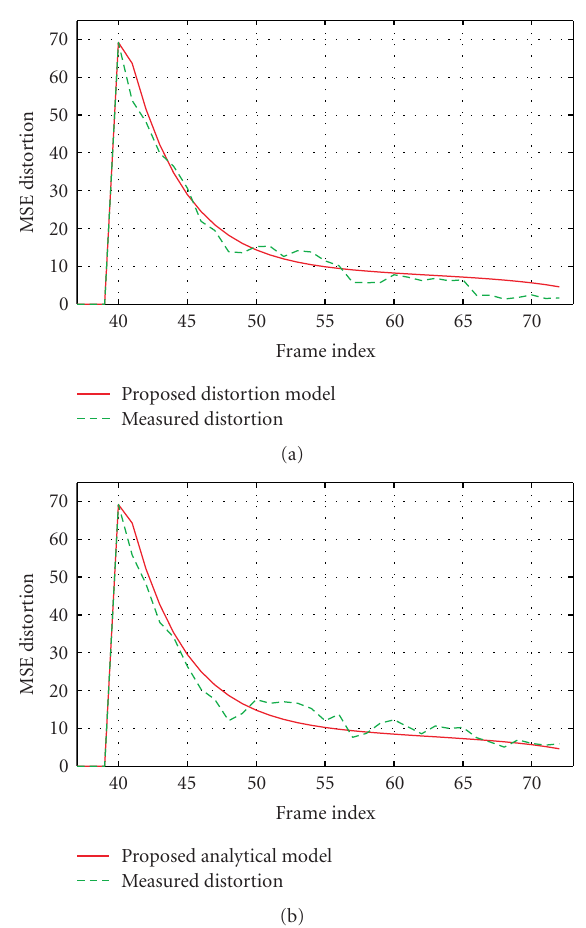
Figure 9: Single frame loss and error propagation. (a) Reference frame list size M REF = 5. (b) Reference frame list size M REF =